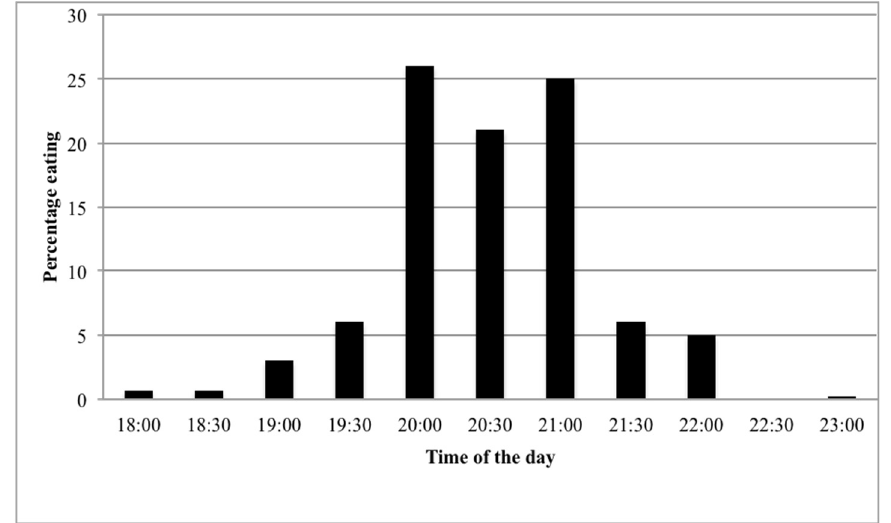
Figure 1. Dinner time. Figure 1. Dinner Table 2. Baseline characteristics of total, early dinner eaters and late dinner eaters.